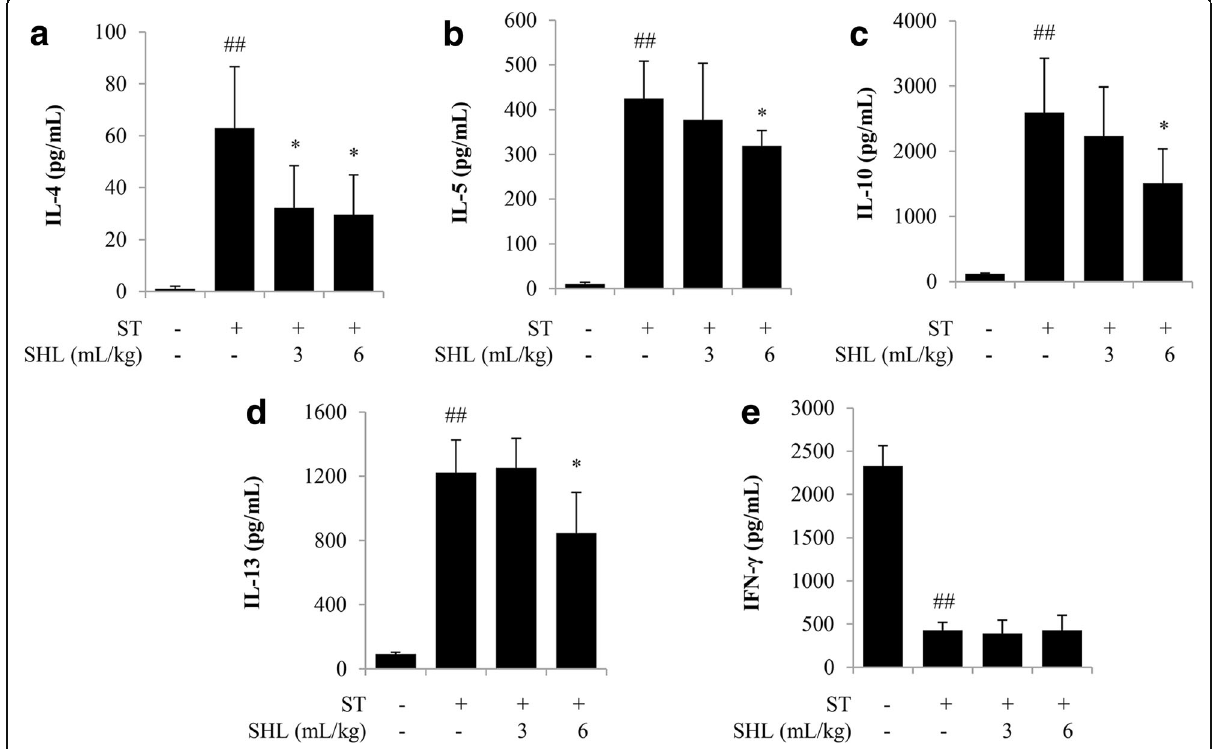
Fig. 2 Effect of SHL on the cytokines produced by splenocytes. The mice were intraperitoneally immunized with ST (60 μ g/mouse) once a week. SHL (3 mL/kg or 6 mL/kg, i.g.) was administered daily to the mice. 4 weeks later the spleens were taken, and single cell suspensions were aseptically prepared. The obtained splenocytes (4×10 6 cells/well) were seeded in a 24-well plate and stimulated with ST (8 μ g/mL) at 37 °C for 72 h. The levels of IL-4 ( a ), IL-5 ( b ), IL-10 ( c ), IL-13 ( d ) and IFN- γ ( e ), in the culture medium, were measured using the ELISA kits. The data represent the means ± SD (n=10). ## P <0.01 vs. the normal control group; * P <0.05 vs. the ST